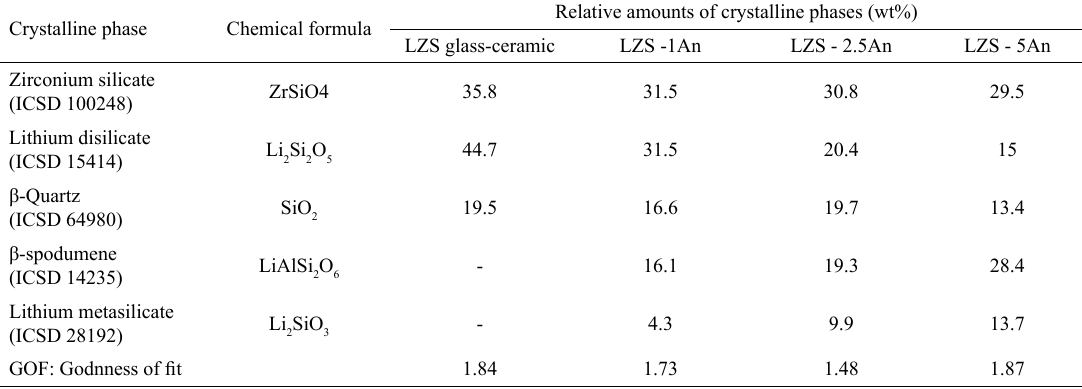
Table 3. Relative amounts of crystalline phases(Rietveld refinement)for samples of the LZS glass-ceramic without and with different alumina additions fired by fast fired at 900 ºC/30 min. Crystalline phase